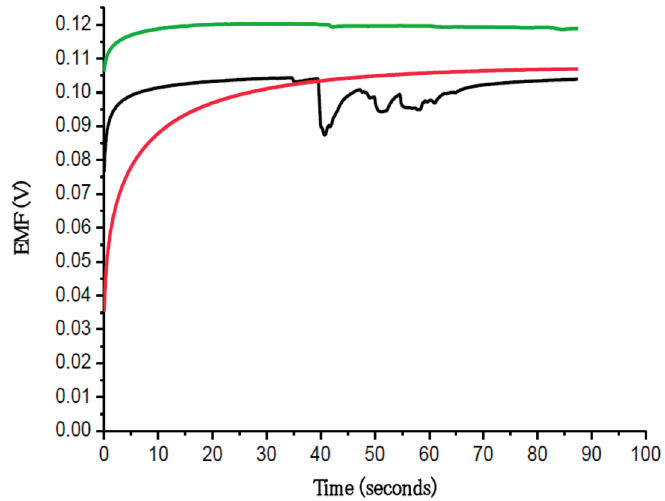
Figure 8. The output response with (black and green) and without (red) interfering ions